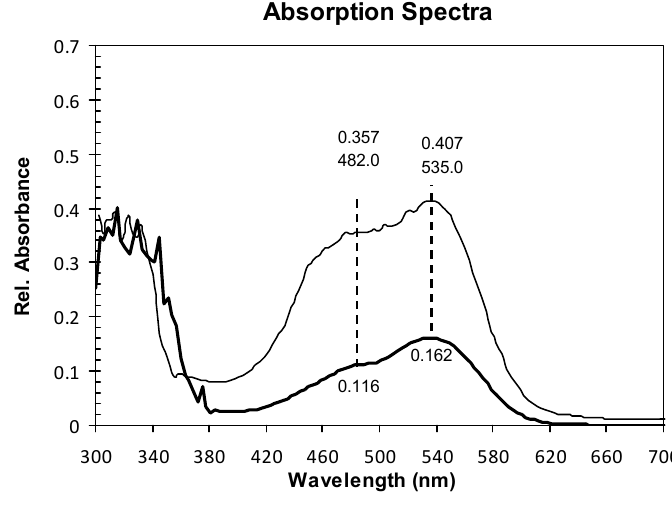
Figure 2. Absorption spectra of the photoanode: BVE/TEOS (thick line) and BVE (thin line), both dipped in a sol-gel solution during 48 h at room temperature. Absorption